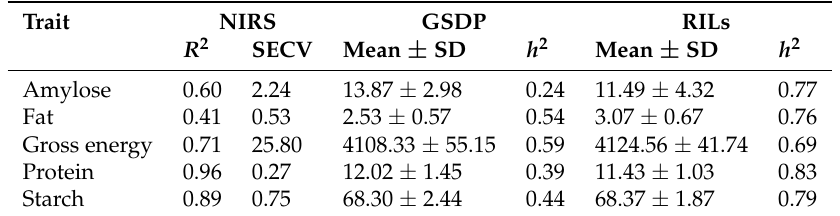
Table 1. Summary statistics of near infra-red spectroscopy (NIRS) calibration and phenotypic distribution. R 2 is the prediction accuracy and SECV is the standard error of cross validation for the NIRS calibration curve. Mean represents the phenotypic mean of the trait with its standard deviation (SD). h 2 is the estimate of genomic